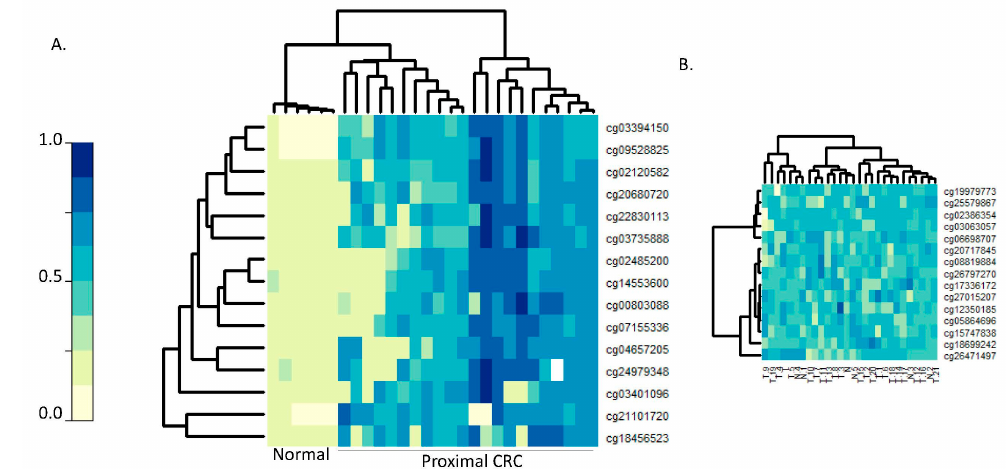
Figure 2. Methylation of dysregulated CpGs in proximal serrated tumors vs. normal mucosa. Proximal serrated tumors ( n = 34) and normal mucosal samples ( n = 15) from the study by Luo et al. [14] are depicted in columns. ( A ) Rows represent the CpGs that were dysregulated in these serrated tumors, which were restricted to the subset of 15 CpGs that were highest ranking for hyper-methylation in our right-sided SSA/Ps from the New Hampshire (NH) Colonoscopy Registry. The methylation levels are reflected by β -values from lowest (light yellow) to highest (dark blue); ( B ) The same Luo et al. [14] proximal serrated tumor and normal samples queried against a randomly selected set of 15 CpGs.